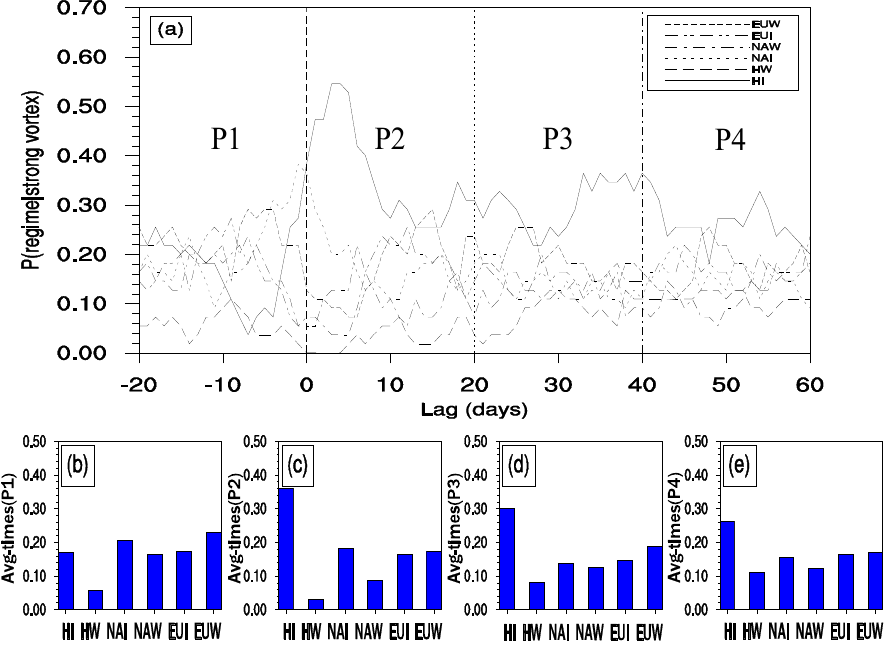
Figure 9. ( a ) The occurrence frequency statistics for the six stratospheric Arctic vortex regimes within days -20 to 60 with respect to the central date of strong stratospheric Arctic vortex events based on three historical runs. ( b – e ) The mean proportion of each polar vortex regimes at the stratosphere for four sub-stages: days -20 to -1 (P1), days 0 to 20 (P2), days 21 to 40 (P3), and days 41 to 60 (P4).